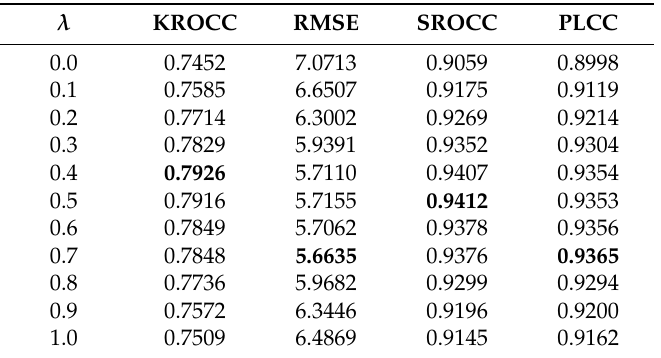
Table 2. Performance of ROI-BRISQUE which ROI extracted by Itti model. The numbers in bold are the best values in the corresponding column.